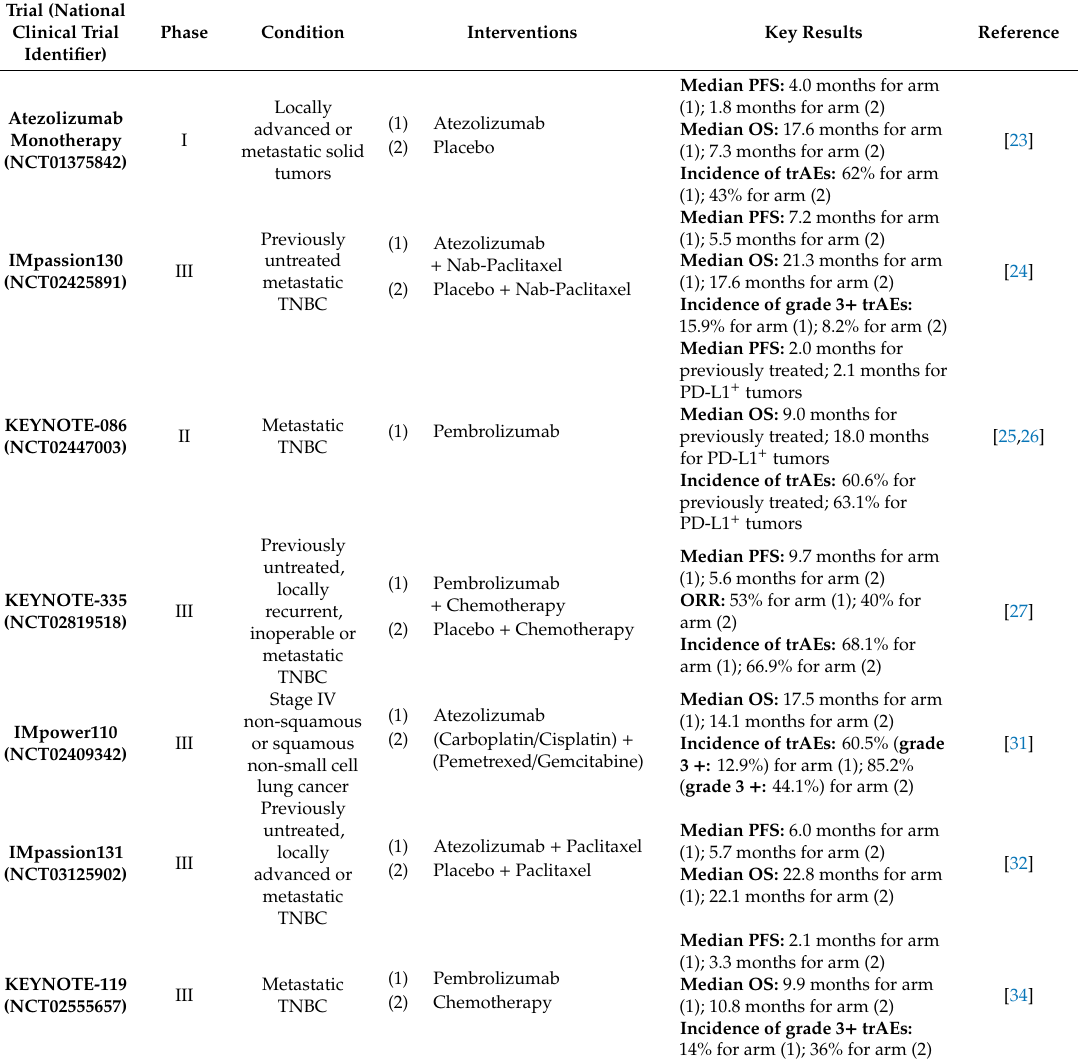
Table 1. List of completed or ongoing clinical trials using PD-1 / PD-L1 immune checkpoint inhibitors. Trial (National Clinical